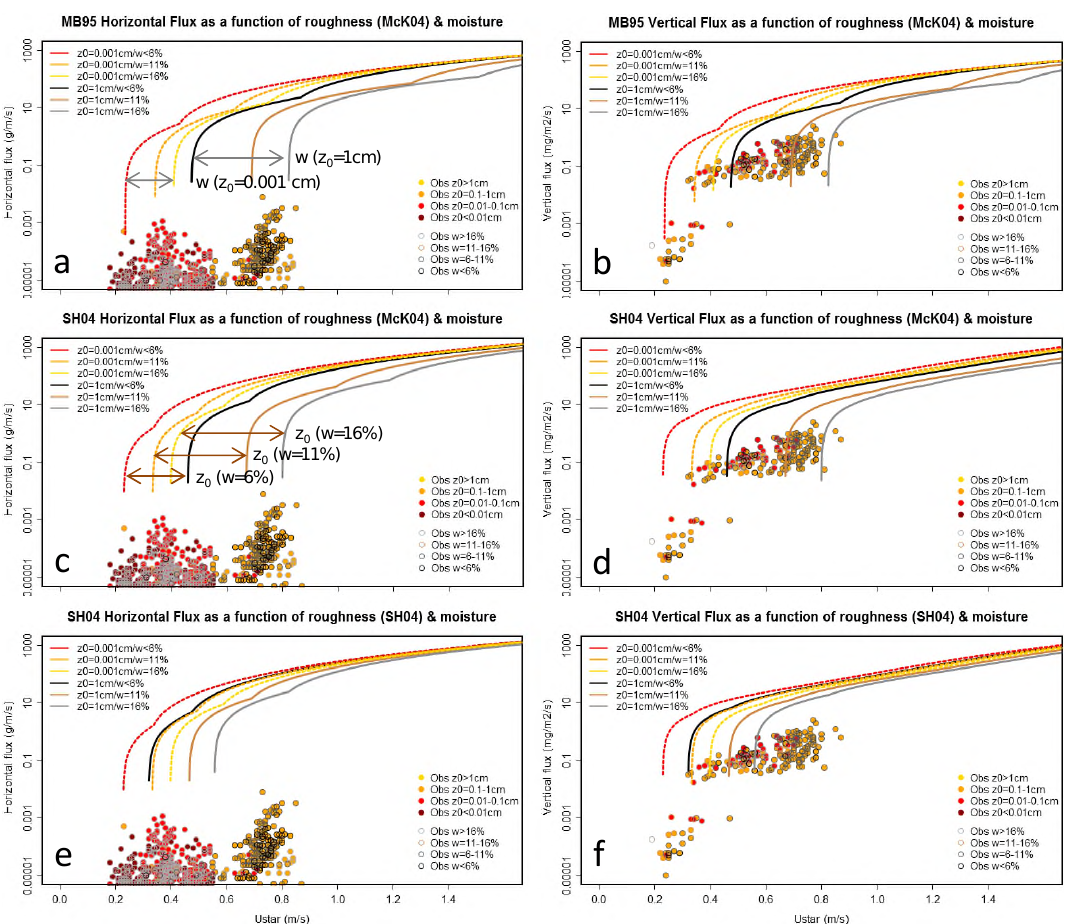
Figure 7. Horizontal and vertical emission fluxes for the baseline Exp. 1a (a, b) and Exp. 4a (c, d, e, f) . The entire range of observed surface roughness and soil moisture is plotted as a function of u ∗ . Likewise, the observational data are split into groups of different roughnesses and moisture. Lowest observed z 0 are indicated by red and dark red dots, and highest observed z 0 by orange and yellow dots (see legend). Lowest observed w are indicated by black and dark grey open circles around the dots, and higher observed w by brown and light grey open circles (see legend). Modelled z 0 are set to two groups of 0.001 and 1cm, whereas modelled w are set to three groups of 6, 11, and 16%,